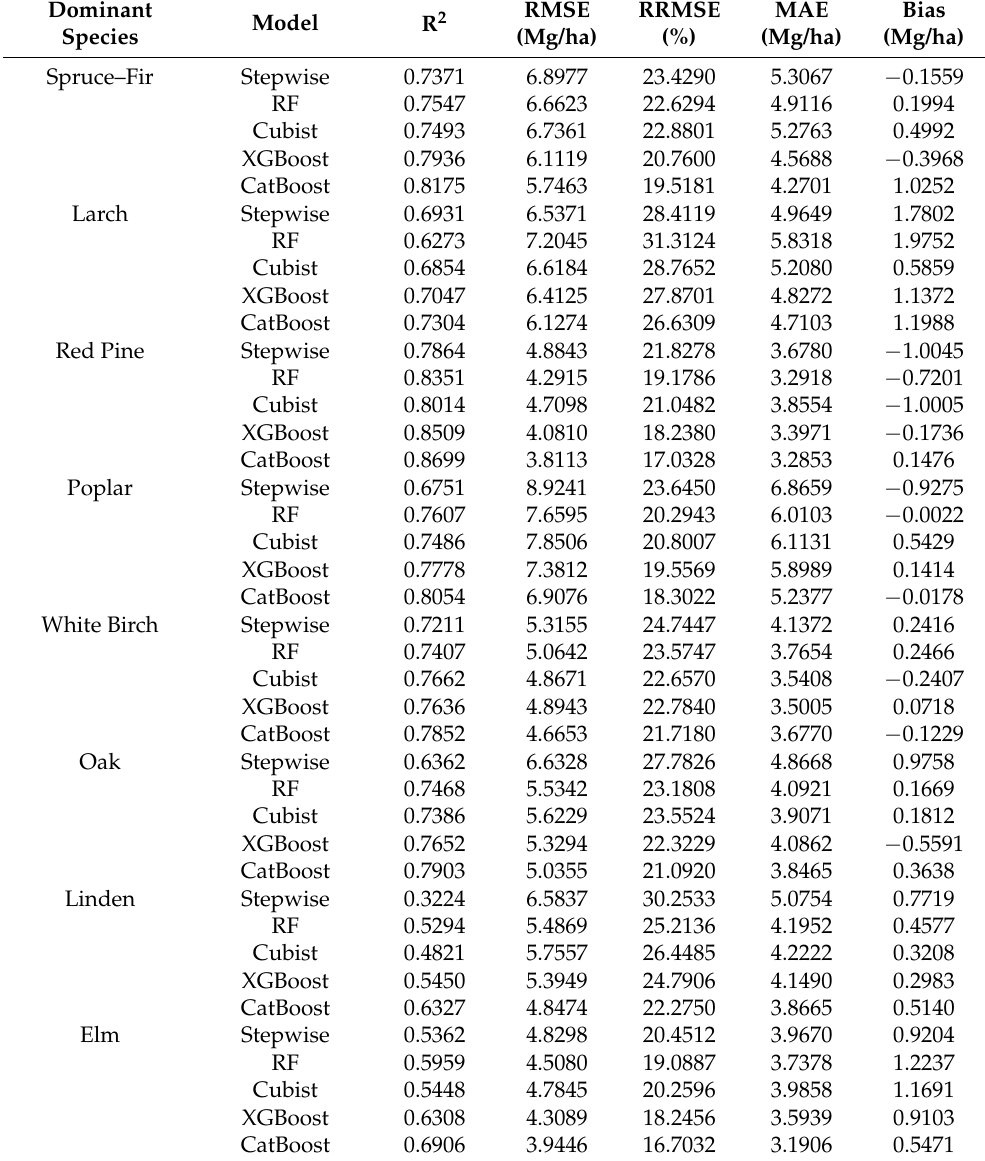
Table 7. Performance of forest AGC estimation models based on DSS in the validation